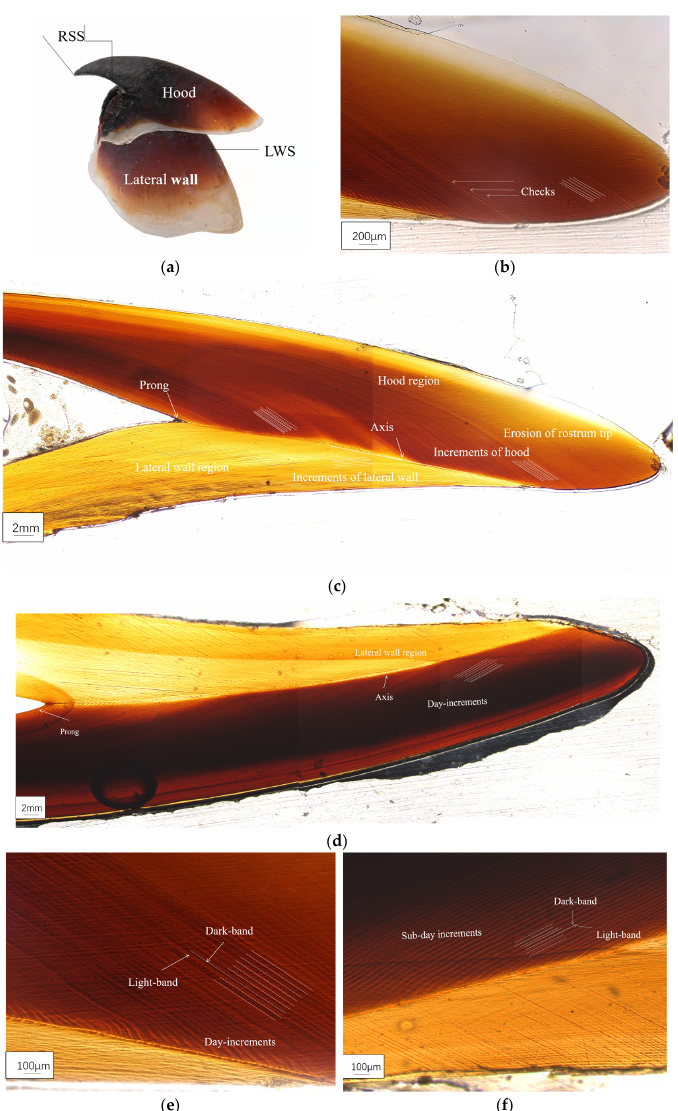
Figure 4. Upper beak microstructure of S. oualaniensis : ( a ) upper beak rostrum; ( b ) growth stripe and marker stripe on the hood; ( c ) upper beak RSS microstructure in 2019; ( d ) upper beak RSS microstructure in 2020; ( e ) light and dark bands and growth stripe in 2019; and ( f ) light and dark bands and growth whorl stripe in